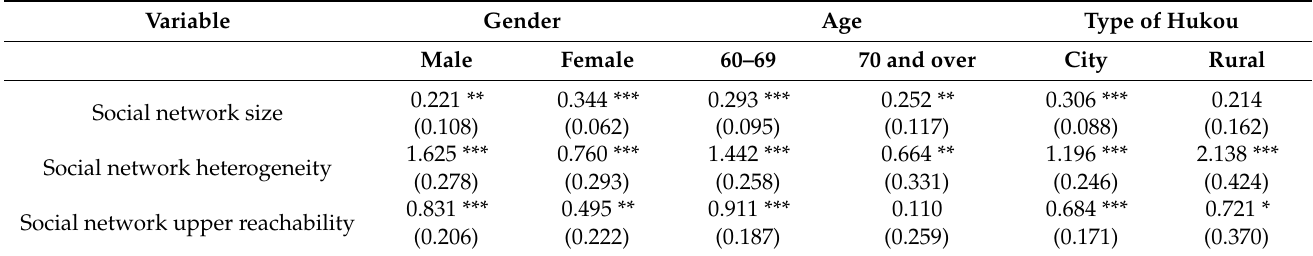
Table 7. Analysis of the influence of Internet use on the social network of the different elderly